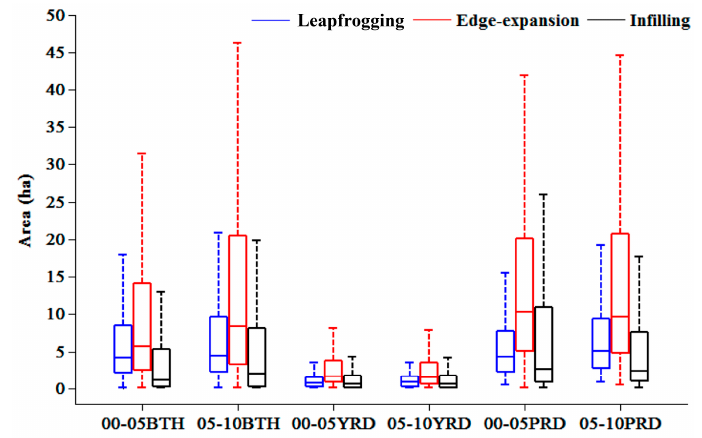
Figure 4. Size distribution for patches of the three expansion models in the BTH, YRD and PRD urban megaregions during 2000–2005 and 2005–2010.